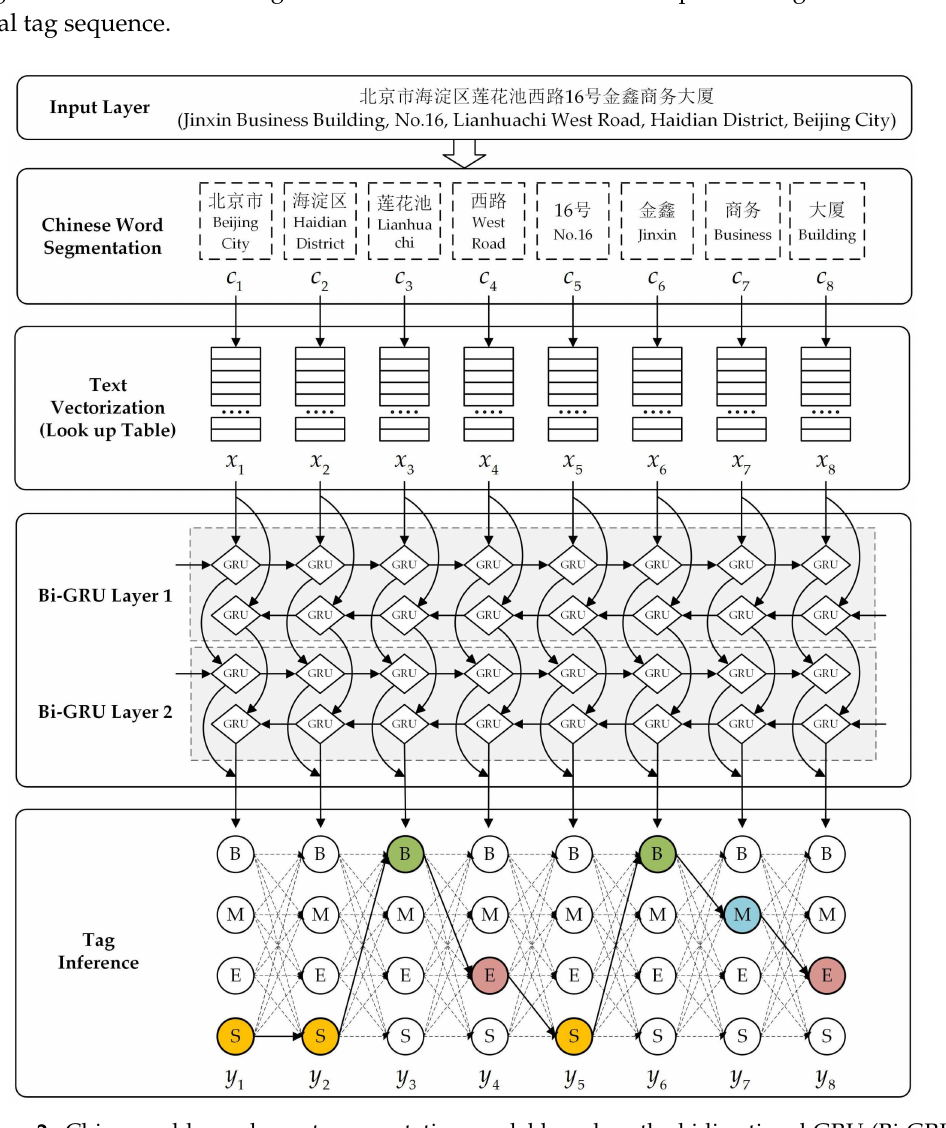
Figure 2. Chinese address element segmentation model based on the bidirectional GRU (Bi-GRU) neural network. The colored tag represents the final tag of the input word. B represents the beginning of the address element, M represents the middle of the address element, E represents the end of the address element, and S represents the single word address